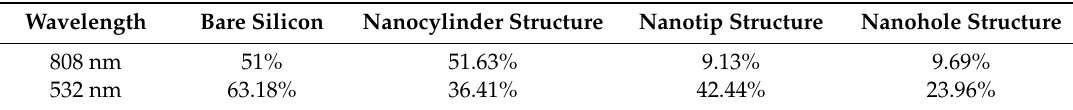
Table 3. The frequency-averaged transmissivity values of the four models at 60 mW / mm 2.